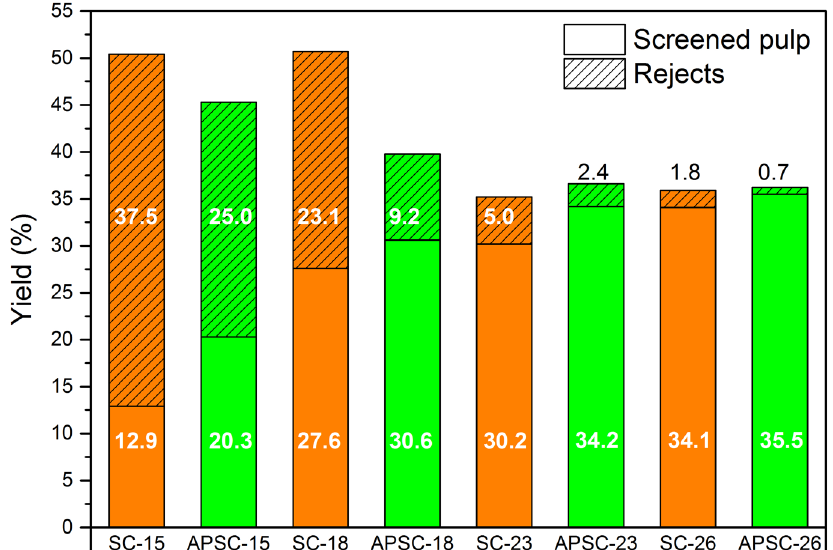
Figure 4. Pulping performance of SC and APSC in terms of yield of screened pulp and yield of rejects at different NaOH dosages. The number after SC or SPSC is NaOH dosage.